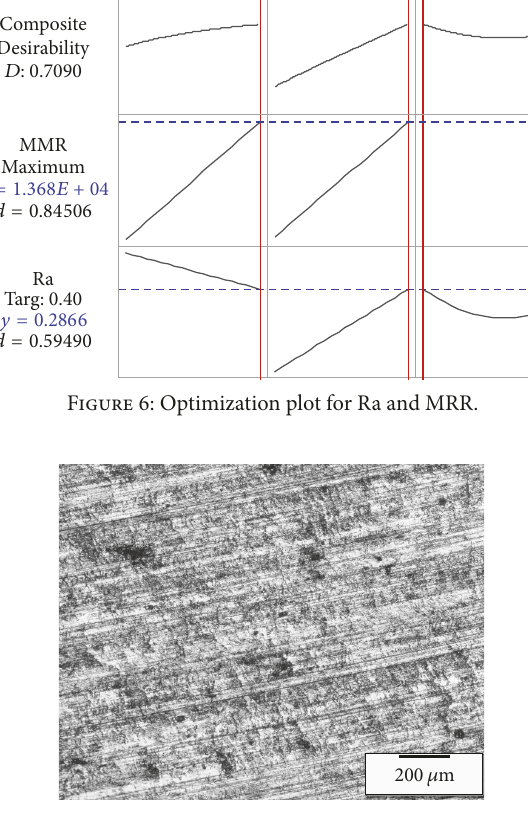
Figure 7: Optical microscopy for machined surface with speed 500 rpm, depth of cut 0.5 mm, and feed rate 150 mm/min.